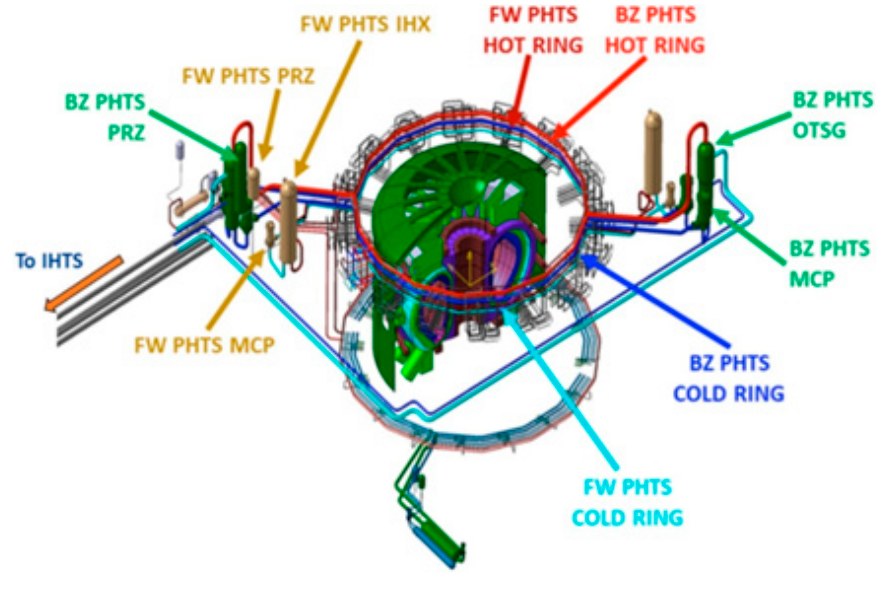
Figure 1. EU DEMO